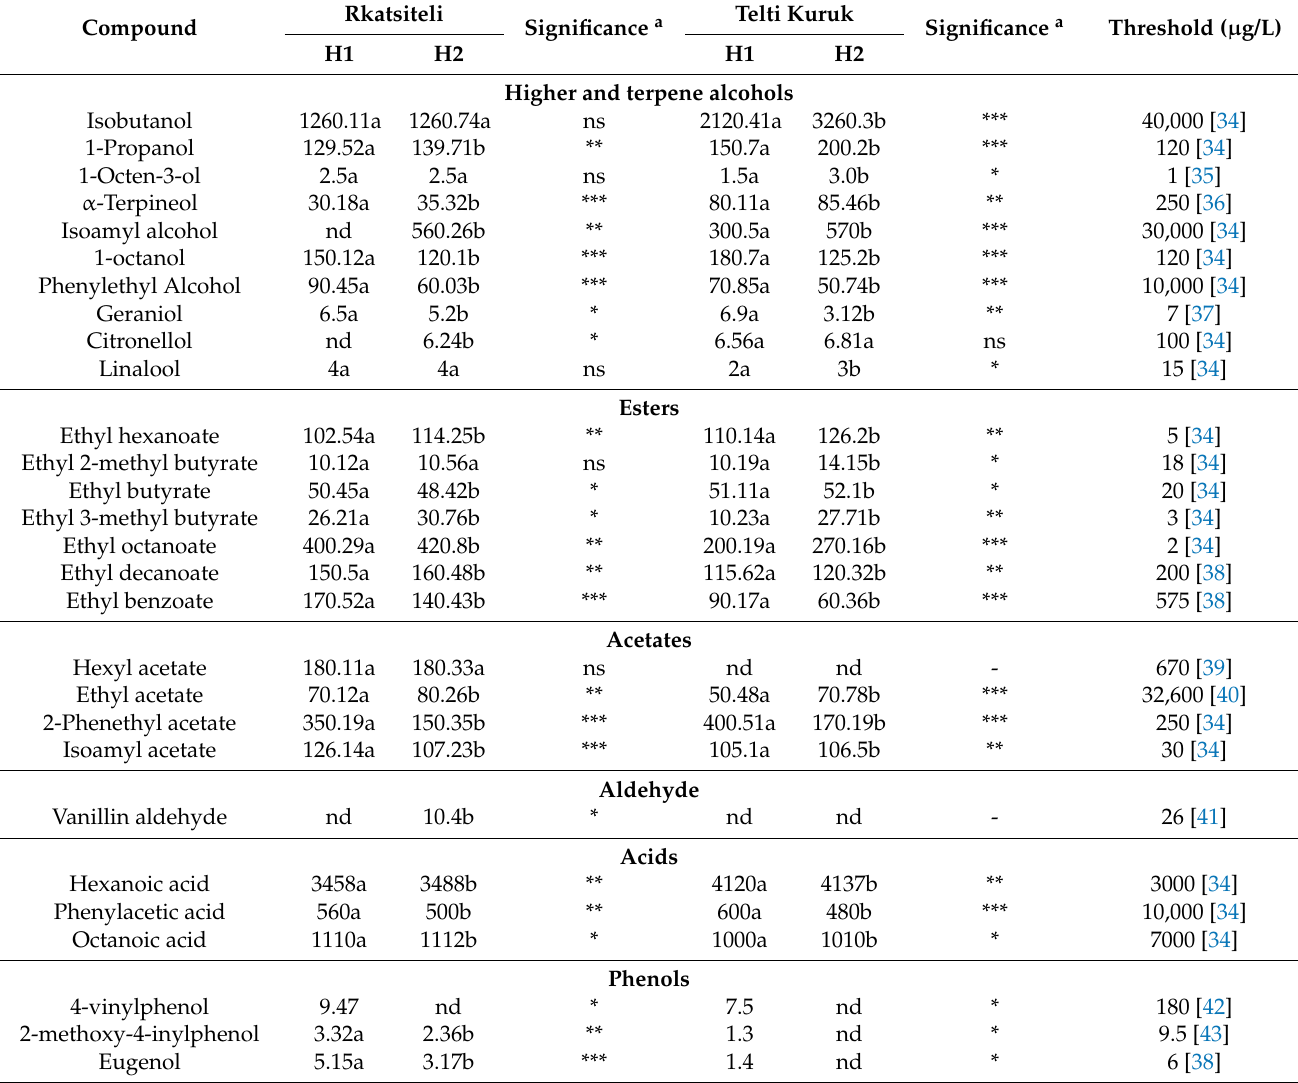
Table 5. Quantitative data of aromatic compounds in Rkatsiteli and Telti kuruk icewines. Rkatsiteli Compound Significance